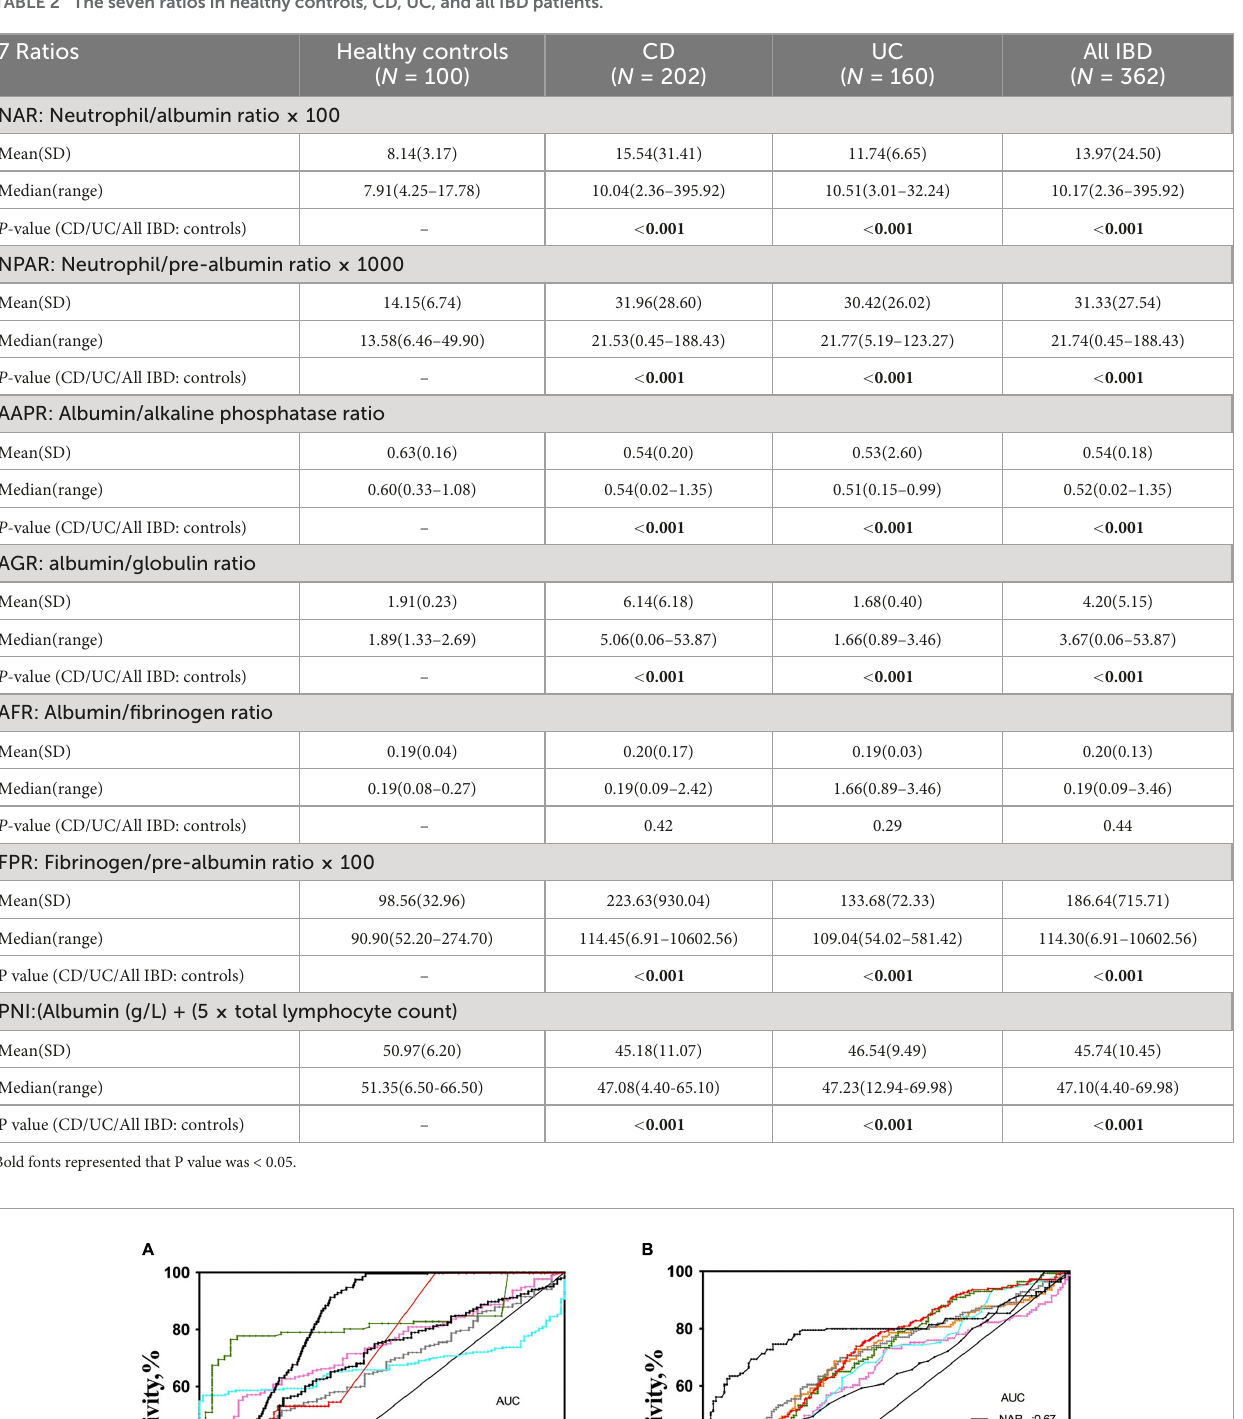
TABLE 2 The seven ratios in healthy controls, CD, UC, and all IBD patients.